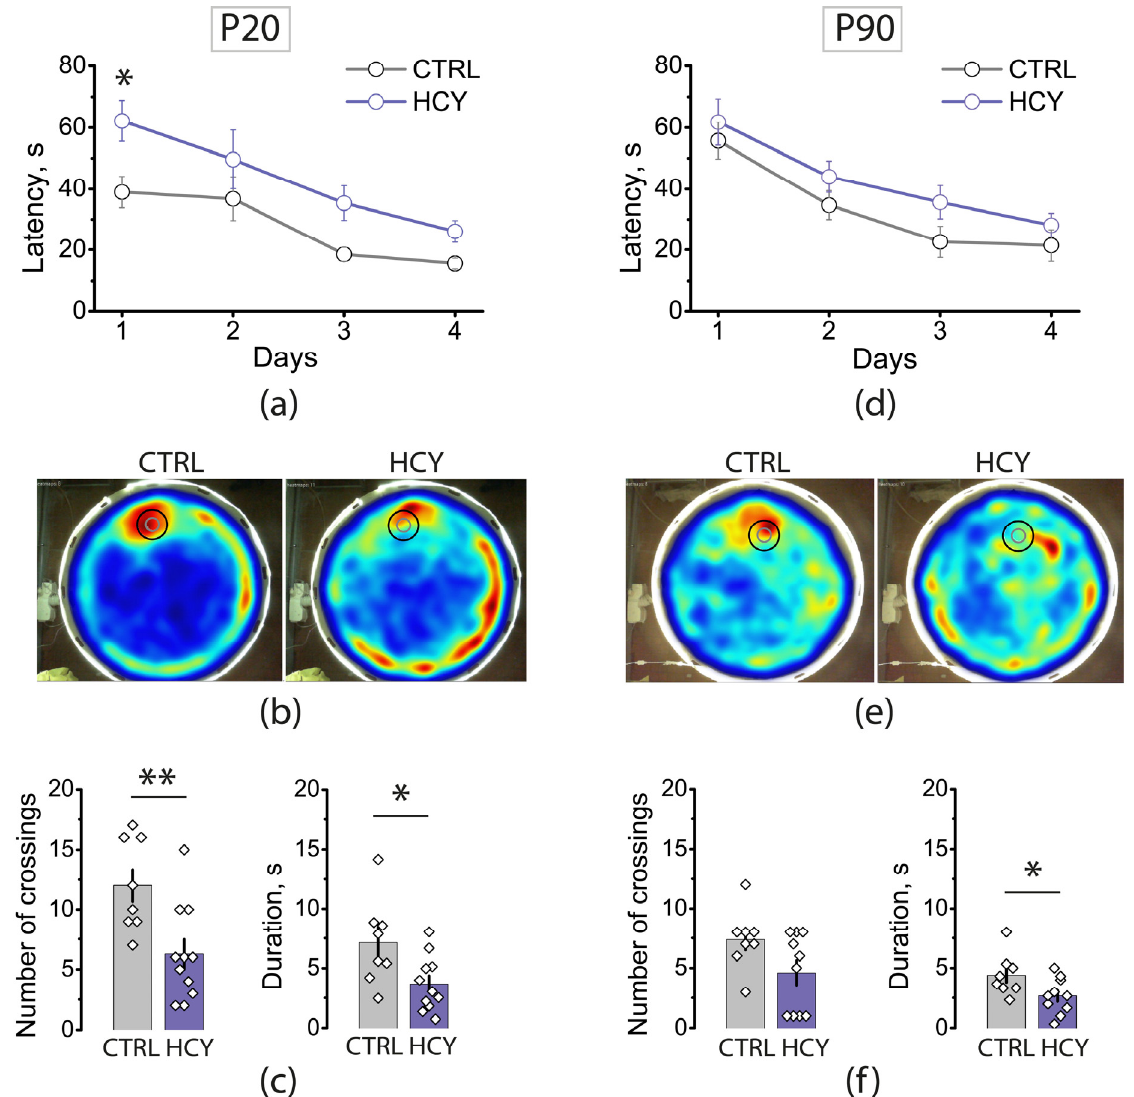
Figure 2. Morris water maze test in control and HCY rats performed at P20 ( a – c ) and P90 ( d – f ). ( a , d ) Average escape latency during training for 1–4 days. ( b , e ) Representative heat maps of Morris water maze obtained at test trial. The gray circle indicates the position of the rescue platform during training sessions, the black circle is the area that was used to count the number of crossings. Increasing color intensity (red) represents increased time spent. ( c , f ) The number of platform area crossings and time spent in the platform area by young ( c ) and adult ( f ) rats. * p < 0.05, ** p < 0.01; two-way ANOVA post hoc Bonferroni’s multiple comparisons for ( a ) and t -tests for ( c ) and ( f ). Spatial memory was evaluated on day 5 (Appendix B Figure A1). On this day, the platform was removed from the pool, and we counted how many times the rat crossed the spent in this area in total. Representative heat maps showed that young and adult control animals spent more time in the target area compared to HCY rats (Figure 2b,e). The mean group (control: 12.0 ± 1.4; HCY: 6.3 ± 1.2; t -test, p < 0.01), whereas the number of crossings area was longer in control rats, both young (control: 7.1 ± 1.3 s; HCY: 3.7 ± 0.7 s; t -test p < 0.05) and adult (control: 4.4 ± 0.6 s; HCY: 2.7 ± 0.5 s; t -test p <